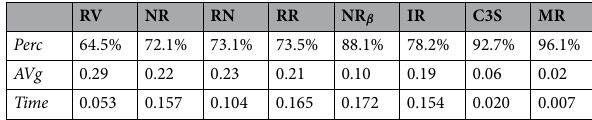
Table 8. Overall results of all